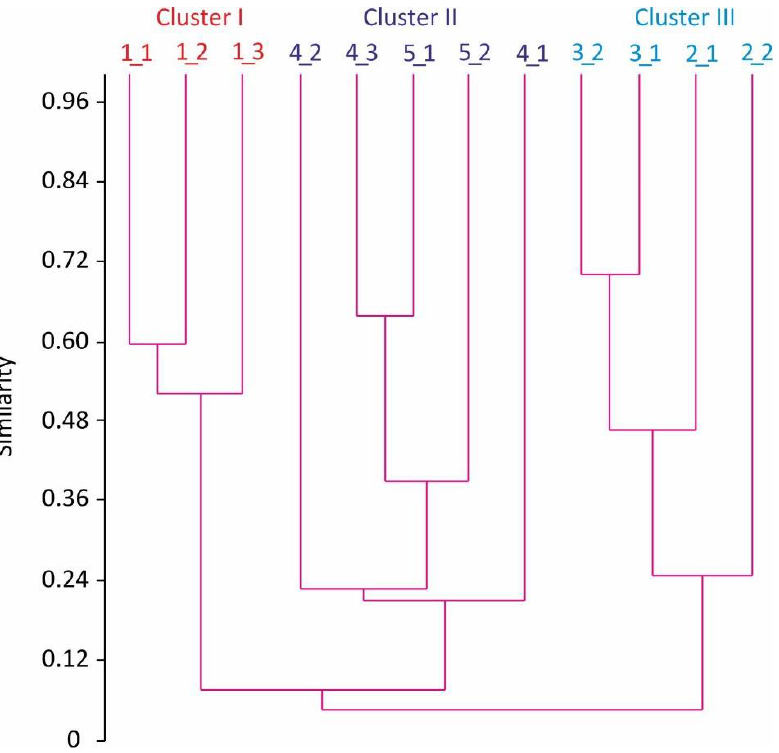
Figure 2. Percent similarity cluster dendrogram of contributions of benthic animals to the total community biomass (%) in Kola Bay.